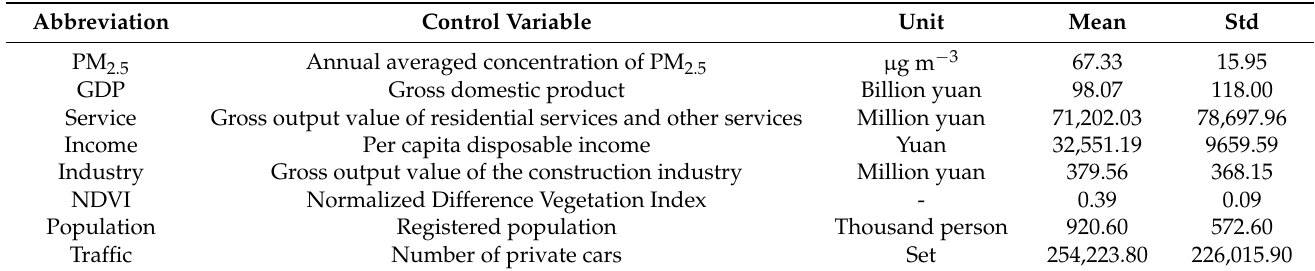
Table 1. The descriptive statistic of all control variables ( n =